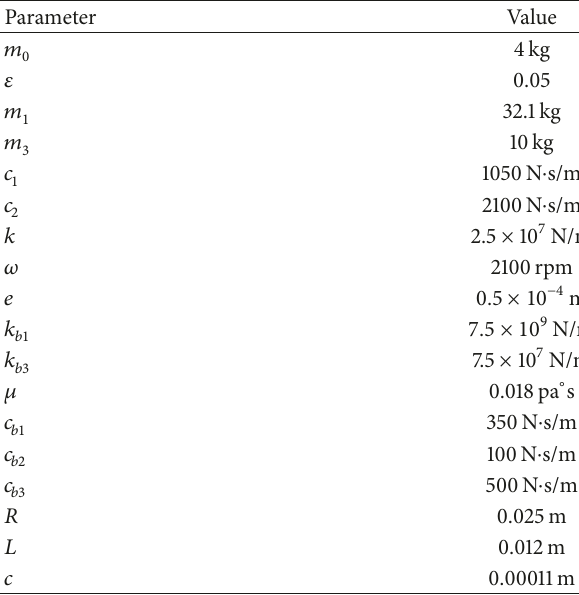
Table 1: Values of simulation